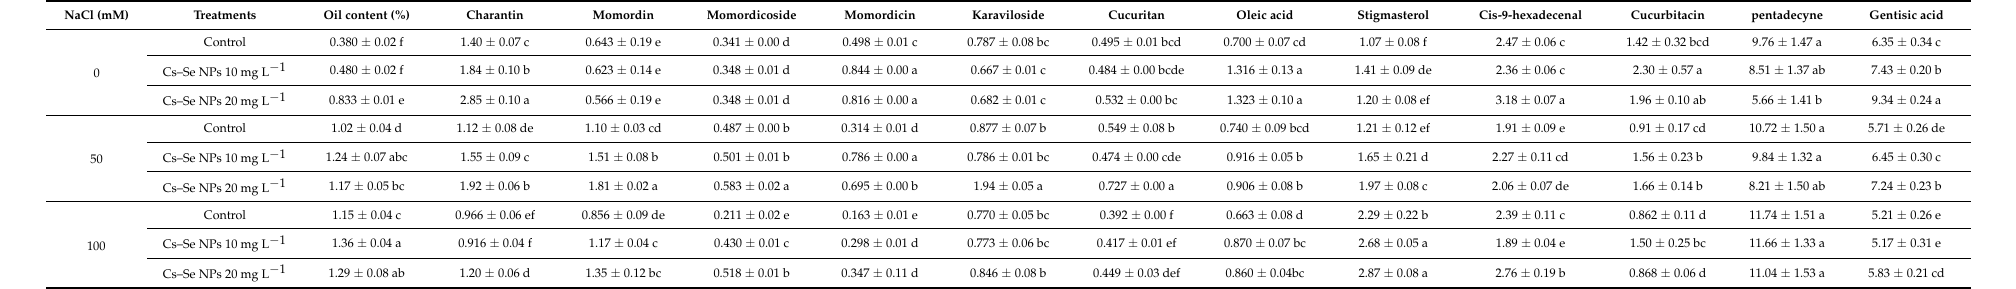
Table 3. Effect of foliar application of Cs–Se NPs (0, 10, and 20 mg L − 1 ) on essential oil content and composition of bitter melon ( Momordica charantia ) fruit from plants grown with 0, 50, and 100 mM NaCl. Data are the mean of 3 replications (n = 3) ± SD, statistically significant difference is given by letters according to the TMRT ( p <